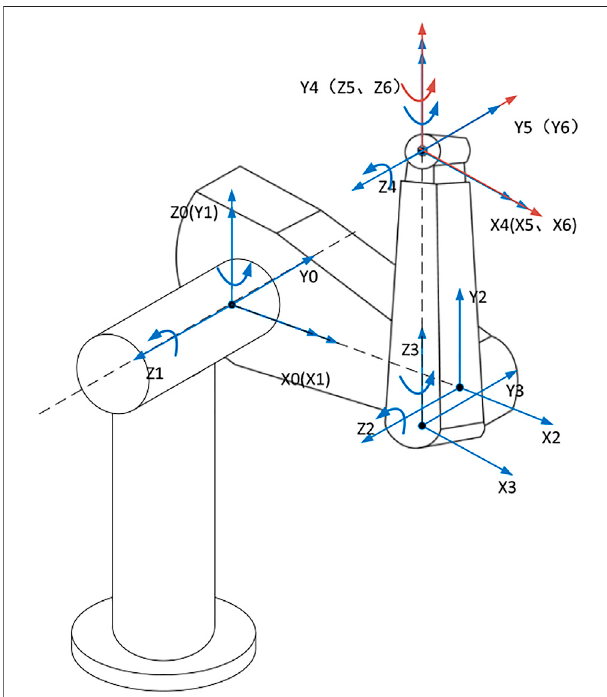
FIGURE 2 | Transformation relationship of the coordinate system of each joint of the manipulator Puma 560.